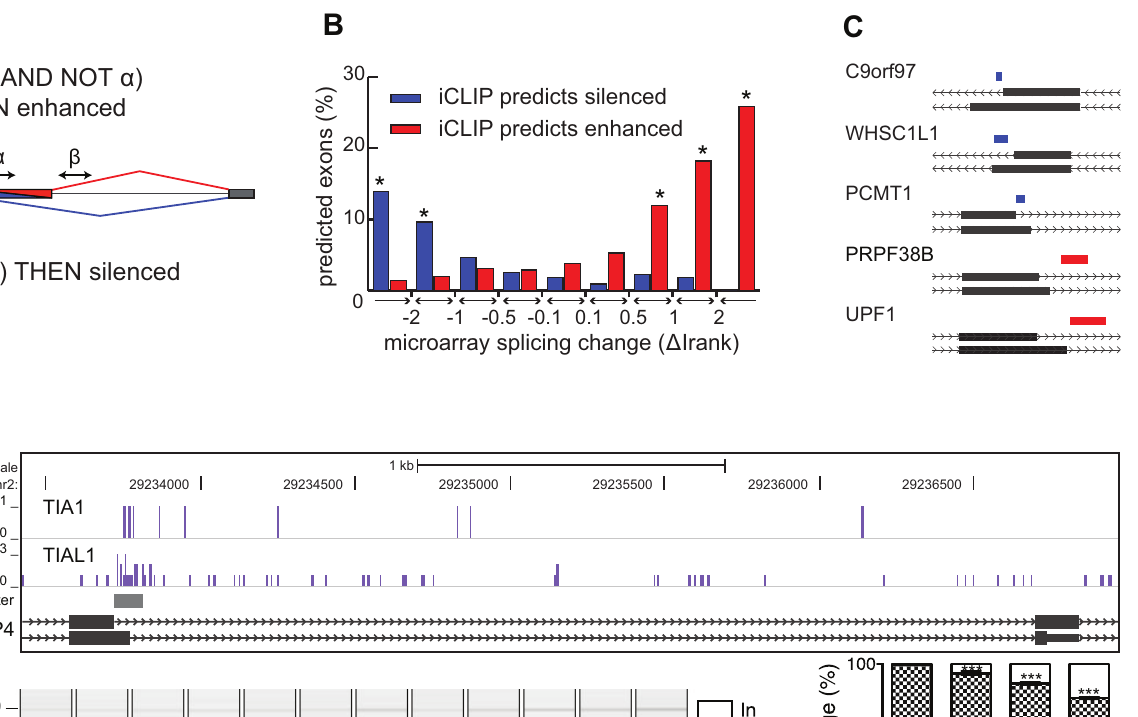
Figure 5. iCLIP predicts the regulation of alternative 5 9 splice sites. (A) Logic functions of the TIA iCLIP code that predict splicing regulation. a and b are regions 10–28 nt downstream of exon/intron boundaries that predict enhanced or silenced exons. (B) The percentage of exons predicted by iCLIP is compared to the splicing change detected by microarray (* p , 0.05, Fisher’s Exact Test). (C) Diagrams showing a section of variable 5 9 splice site isoforms of five pre-mRNAs (given on the left) predicted by iCLIP and validated by RT-PCR. The relative location of cDNA clusters is shown as a blue line at silenced and red line at enhanced variable exons. (D,E) iCLIP crosslink sites surrounding the enhanced variable-length exon in CLIP4 pre-mRNA (D) and silenced variable-length exon in CHD9 pre-mRNA (E). Depiction and labelling is as described in the legend for Figure 3D–E.